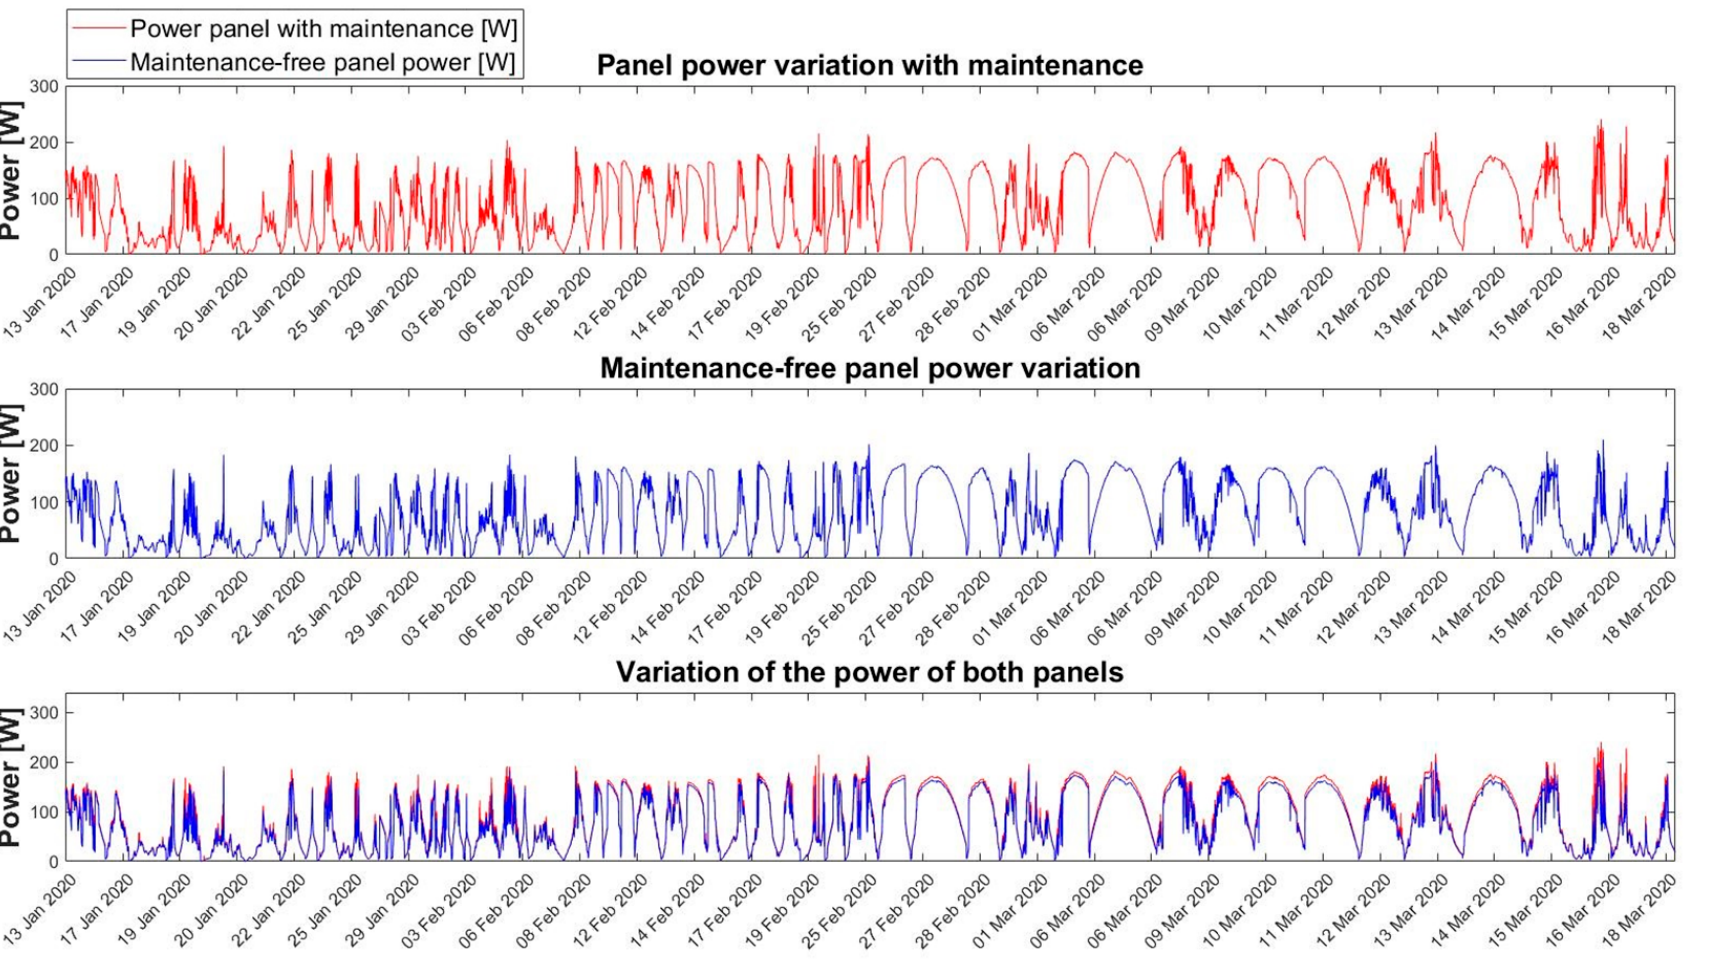
Figure 4. Representation of the power variation in the two panels studied along with the filtered values.